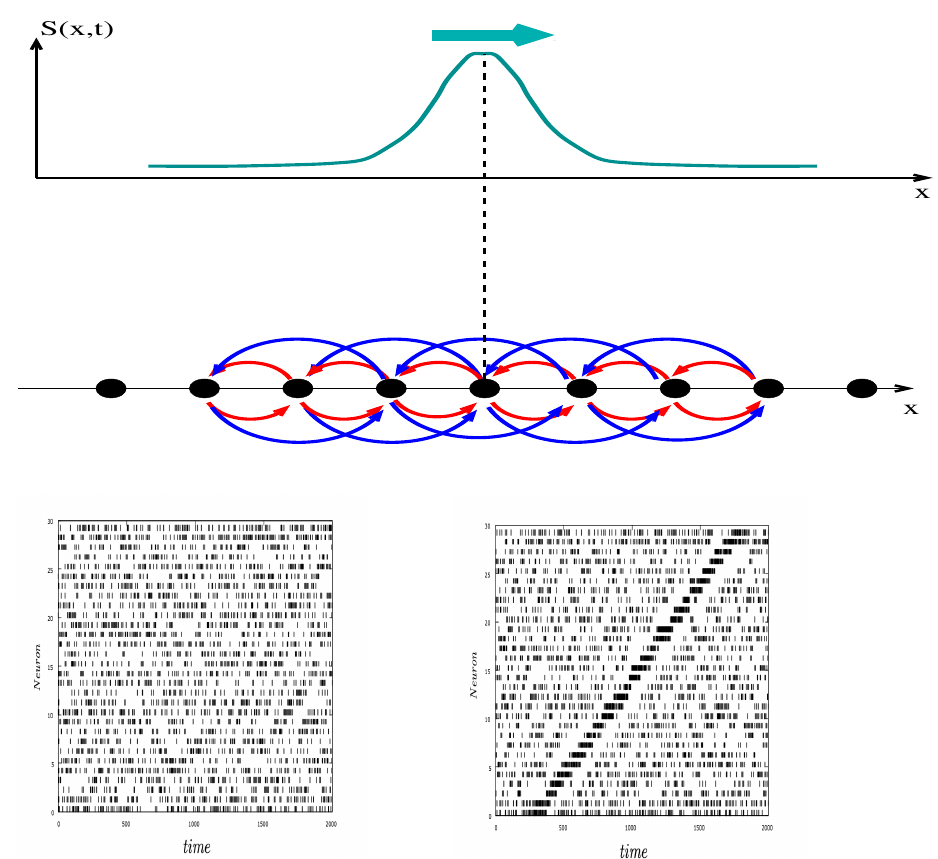
Figure 3. ( Top ) Network of spiking neurons sensing a stimulus (Redrawn from ref. [51]). Each neuron, represented as a black point, is connected to its neighbours with an excitatory connection (red arrows) and to its second nearest neighbours with an inhibitory connection (blue arrows). In addition, each neuron is able to sense external stimuli S ( x , t ) (cyan, bell shaped curve). ( Bottom Left ) Spontaneous spiking activity. ( Bottom Right ) Spiking activity in the presence of the moving